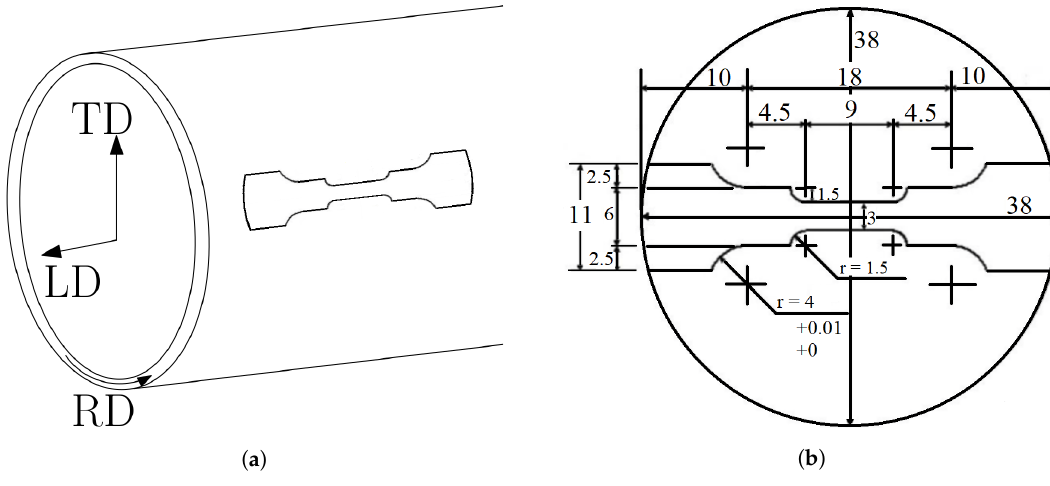
Figure 2. ( a ) an illustration on how the specimens were taken from the SDSS pipe and gives the definition of LD, RD and TD. The specimen dimensions is magnified compared to the pipe for illustration purpose; ( b ) specimen geometry, with all measurements in mm. The specimen had an original thickness of 2 mm before grinding and polishing.